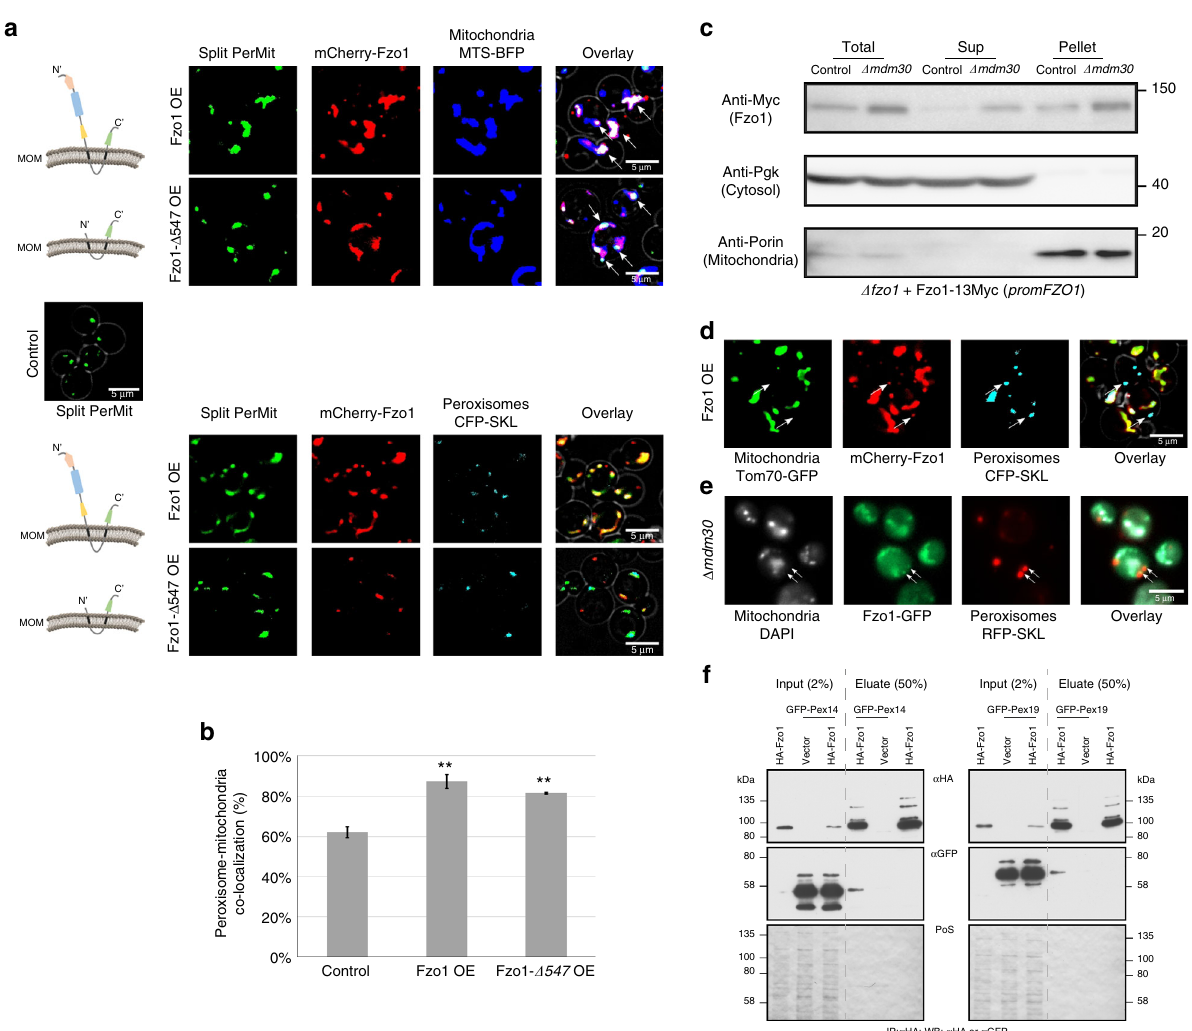
Fig. 4 Fzo1 has characteristics of a tether for the PerMit contact site. a Overexpression of full-length (mCherry-Fzo1) or truncated (mCherry-Fzo1 Δ 547 ) Fzo1 (control cells and schemes of Fzo1 on left). When full-length Fzo1 is overexpressed, mitochondria (marked by MTS-BFP) are hyper-fused (as previously described) yet Fzo1 is still only localized to mitochondrial patches in proximity to peroxisomes and to the contact (white arrows). All PerMits co-localize with Fzo1. Overexpression of truncated Fzo1 does not alter mitochondrial morphology, is suf fi cient for mediating PerMit expansion and enables Fzo1 localization to the PerMit site. Overexpression of full length or truncated Fzo1 does not affect peroxisomes (marked by CFP-SKL) number and size. b Quanti fi cation of peroxisomes that co-localize with mitochondria in control, full length or truncated Fzo1 overexpression. Bars represent the mean ± s.e. from three independent experiments. one-tail Student ’ s t -test, ** p < 0.01. c Total lysates from control and Δ mdm30 cells, in which native Fzo1 is tagged with 13Myc epitopes (Fzo1-13Myc), were subjected to subcellular fractionation yielding soluble (Sup) and mitochondria-enriched (Pellet) fractions. The distinct fractions were analyzed by immunoblotting with anti-Myc (Fzo1), anti-Pgk (a cytosolic marker) and anti-Porin (a mitochondrial marker) antibodies. Fzo1 is found in a non-mitochondrial fraction more readily visible when a slight increase in Fzo1 levels is created by deleting MDM30 . d Fzo1 overexpression by a strong TEF2 promoter demonstrates Fzo1 signals that do not co-localize with mitochondria (marked by Tom70-GFP) but rather with peroxisomes (marked by CFP-SKL) (white arrows). e MDM30 depletion demonstrating that Fzo1-GFP is localizes to both mitochondria (marked by DAPI) and peroxisomes (marked by RFP-SKL) (white arrows). f A physical interaction between Fzo1 and Pex14/Pex19. HA-Fzo1 or its corresponding empty vector were expressed in control, GFP-Pex14, or GFP-Pex19 strains. HA-Fzo1 was immunoprecipitated from solubilized crude membrane extracts using HA-coupled beads.